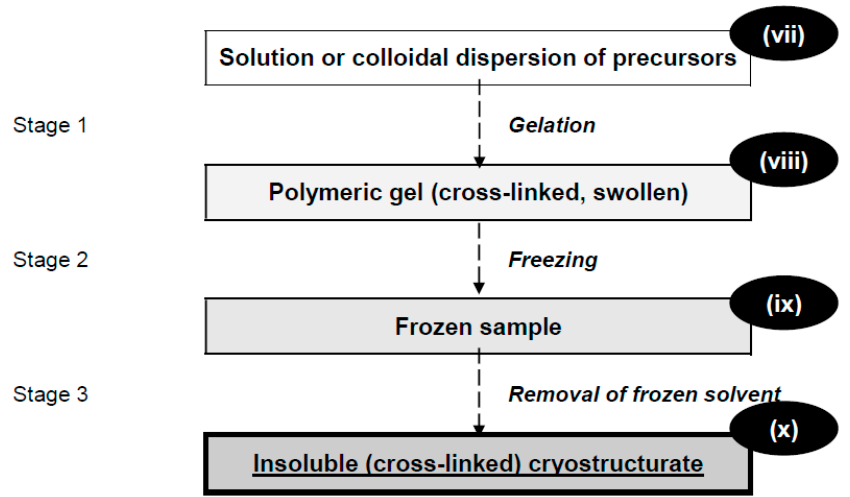
Figure 2. The diagram of the pre ‐ formed gel matter cryostructuring.